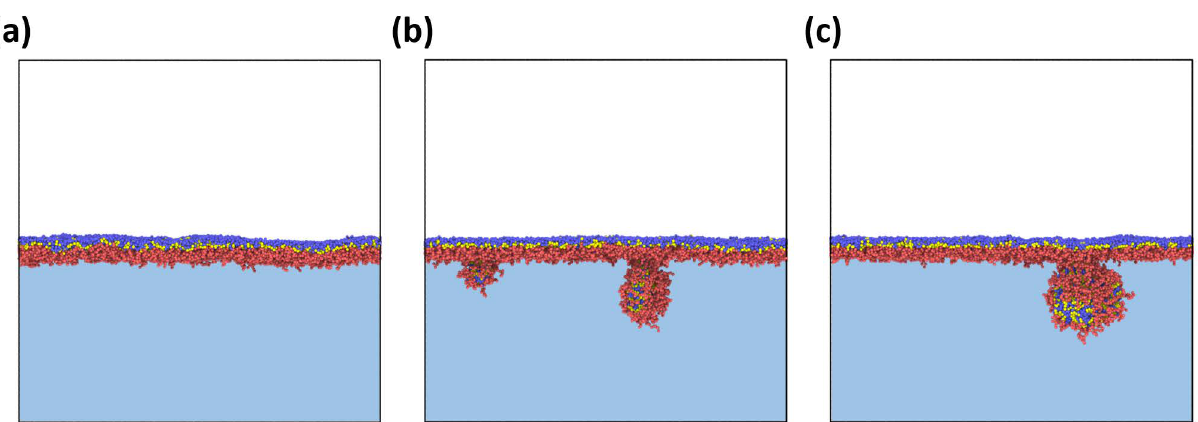
Figure 6. Side views of a strongly compressed bottlebrush monolayer at different simulation times: ( a ) right after the end of compression, t = 0 steps; ( b ) t = 1 × 10 6 steps; and ( c ) t = 2 × 10 6 steps. The interfacial area of L x × L y = 30 × 100. The bottlebrush architecture parameters are: n b = 3, n bb = 100, and f a =